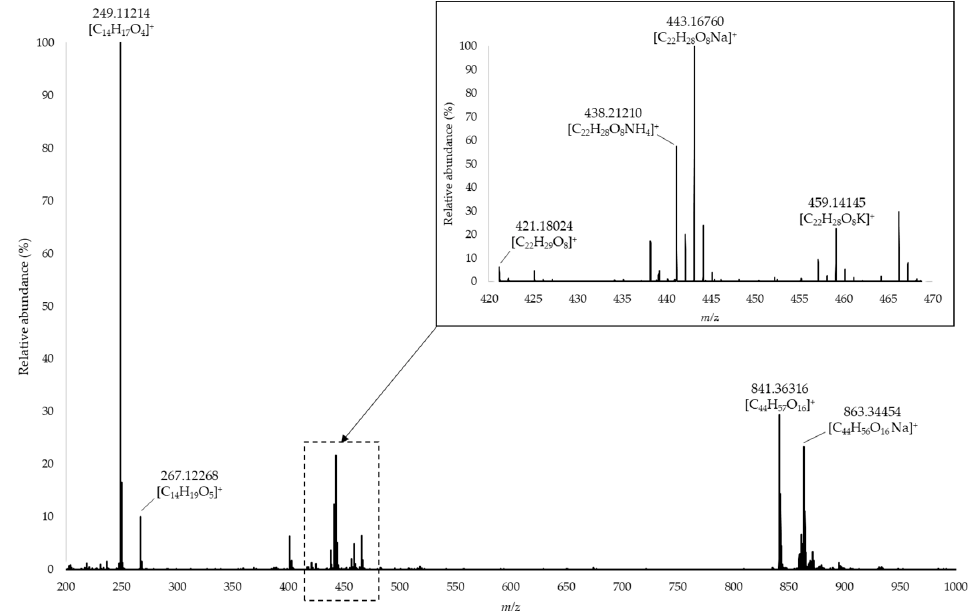
Figure 3. High resolution mass spectrometry (HRMS) spectrum of ( ± )-lyoniresinol in positive ionization mode.